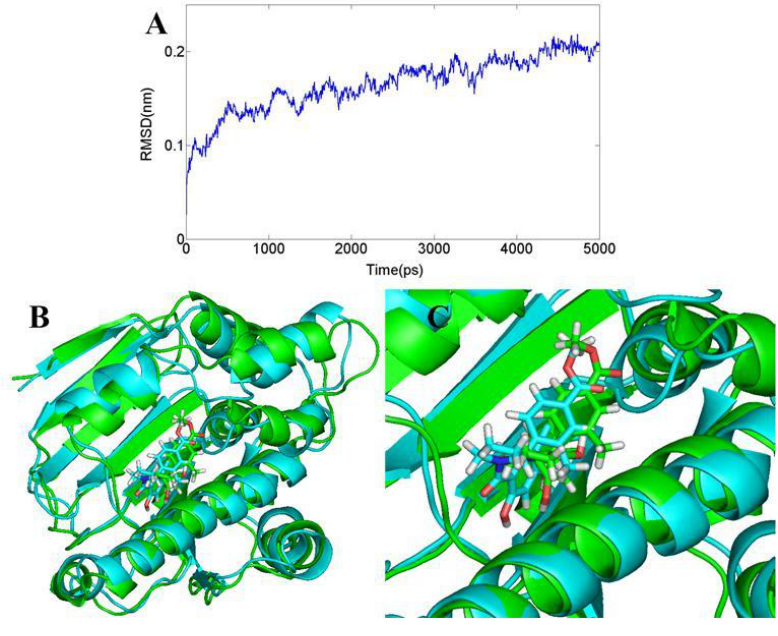
Figure 14. ( A ) Plot of the root-mean-square deviation (RMSD) of docked complex versus the MD simulation time in the MD-simulated structures; ( B ), ( C ) View of superimposed backbone atoms of the lowest energy structure of the MD simulation (cyan) and the initial structure (green) for compound 19-3K97 complex. Compound 19 is represented as carbon-chain in green for the initial complex and carbon-chain in cyan for the lowest energy